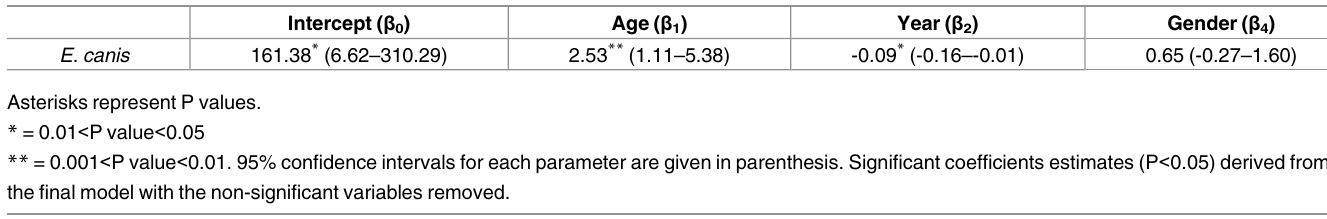
Table 2. Parameterestimatesfor logistic regression models of seroprevalence to Ehrlichia canis .